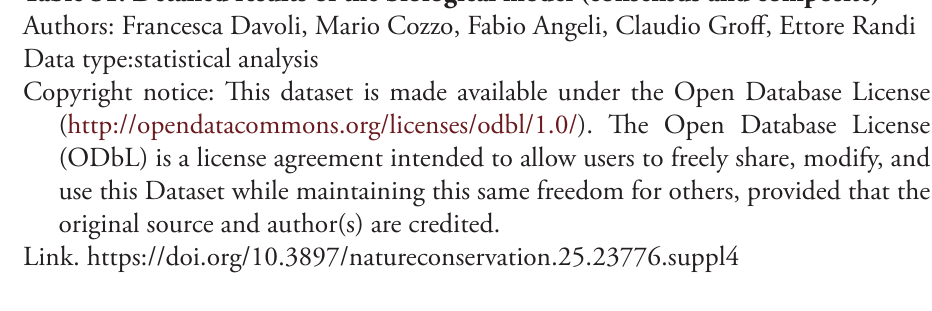
Table S1. Detailed results of the biological model (consensus and